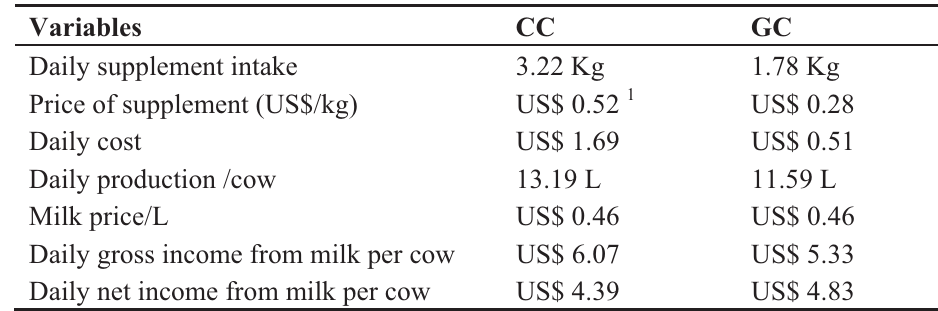
Table 7. Economic impact of supplementing grazing cows with commercial concentrate (CC) or ground corn (GC). All other costs considered the